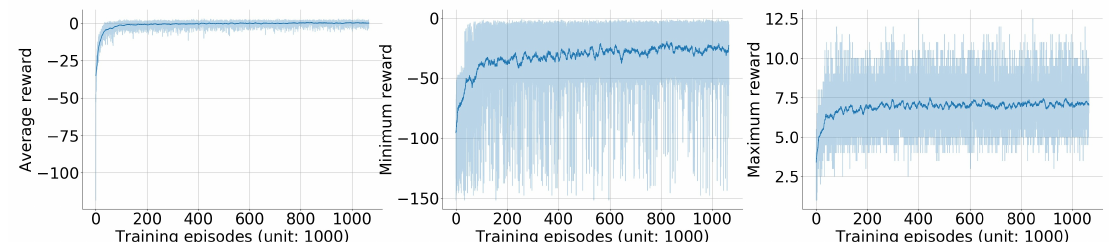
Figure 7. Training curves of the episode reward. One episode is one round of the searching task, starting from initializing the simulation environment and ending with the detector triggering the termination condition (either finding the source or reaching the maximum time step inside an episode). Between every 100 training episodes, 30 randomly initialized episodes were evaluated with CNN parameters fixed. Plot ( a ) shows the average testing reward of the 30 episodes. Plot ( b ) shows the minimum testing reward of the 30 episodes. Plot ( c ) shows the maximum testing reward of the 30 episodes. In these three plots, dark blue lines represent the averaged testing results with window size of 100 episodes, while light blue shadows represent raw testing